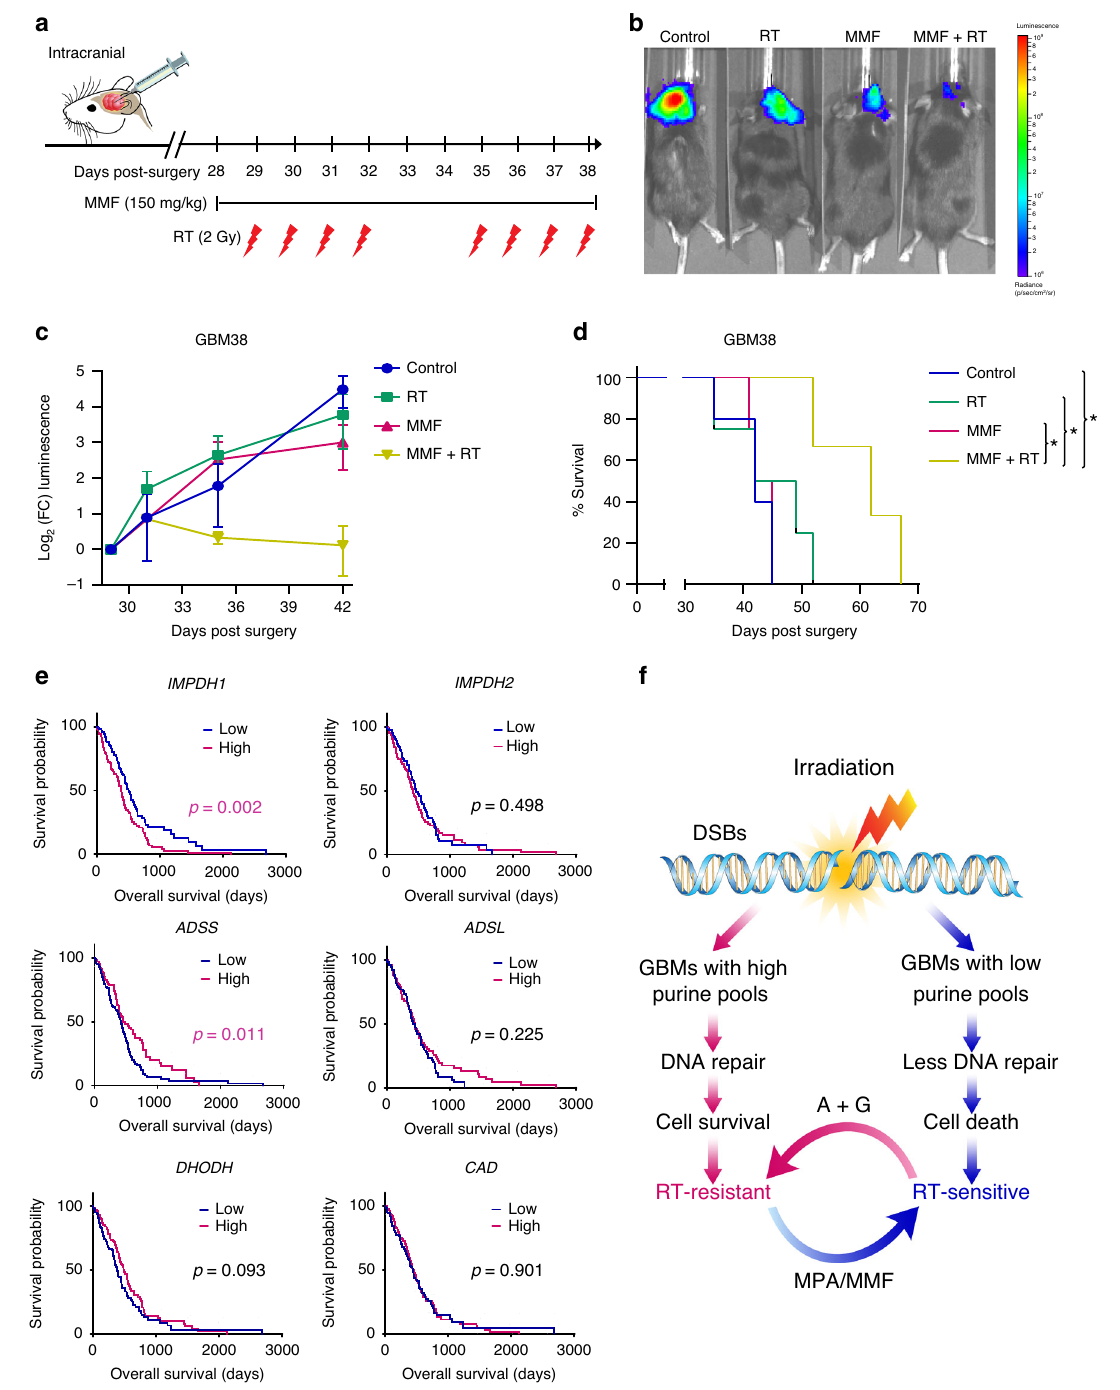
Fig. 7 Purine metabolism mediates RT resistance in an orthotopic patient-derived GBM model. a Luciferase-positive RT-resistant GBM38 patient- derived xenograft cells were orthotopically implanted and, 28 days later, brain tumor-bearing mice were randomized to treatment with drug vehicle, RT, MMF, or MMF + RT (3 – 5 animals per group). MMF was administrated from Day 28 to 38 (11 doses), and RT was given from Day 29 to 32 and Day 35 to 38, respectively. b Mice were treated with 150 mg/kg D-luciferin and imaged 10 min post-injection. c Total fl ux of equal-area ROIs at each time point were normalized to fl ux at the fi rst day of treatment and used to approximate tumor progression. Data are presented as mean ± SEM from three (MMF + RT) or four (Control, RT, MMF) independent mice per group. d Kaplan – Meier survival curve. Mice were monitored daily and euthanized when they developed neurologic symptoms. p value for RT vs. MMF + RT is 0.0409; 0.0213 for MMF vs. MMF + RT; 0.0151 for Control vs. MMF + RT; * p < 0.05. The p value was obtained by the log-rank (Mantel – Cox) test. e Kaplan – Meier overall survival curve of 208 patients from the Pan-Cancer Atlas with newly diagnosed IDH wild type GBM. High and low groups are de fi ned by median expression of key rate limiting enzymes of nucleotide synthesis. The p values were obtained using the log-rank (Mantel – Cox) test. f Working model. RT induces DSBs in GBMs. High de novo purine synthesis promotes GBM survival by stimulating dsDNA repair, cell survival and recurrence after RT. Supplementing cells with purines (A + G) promotes RT-resistance while inhibiting de novo purine synthesis with mycophenolic acid (MPA) or mycophenolate mofetil (MMF) promotes RT-sensitivity. Source data are provided as a Source Data fi